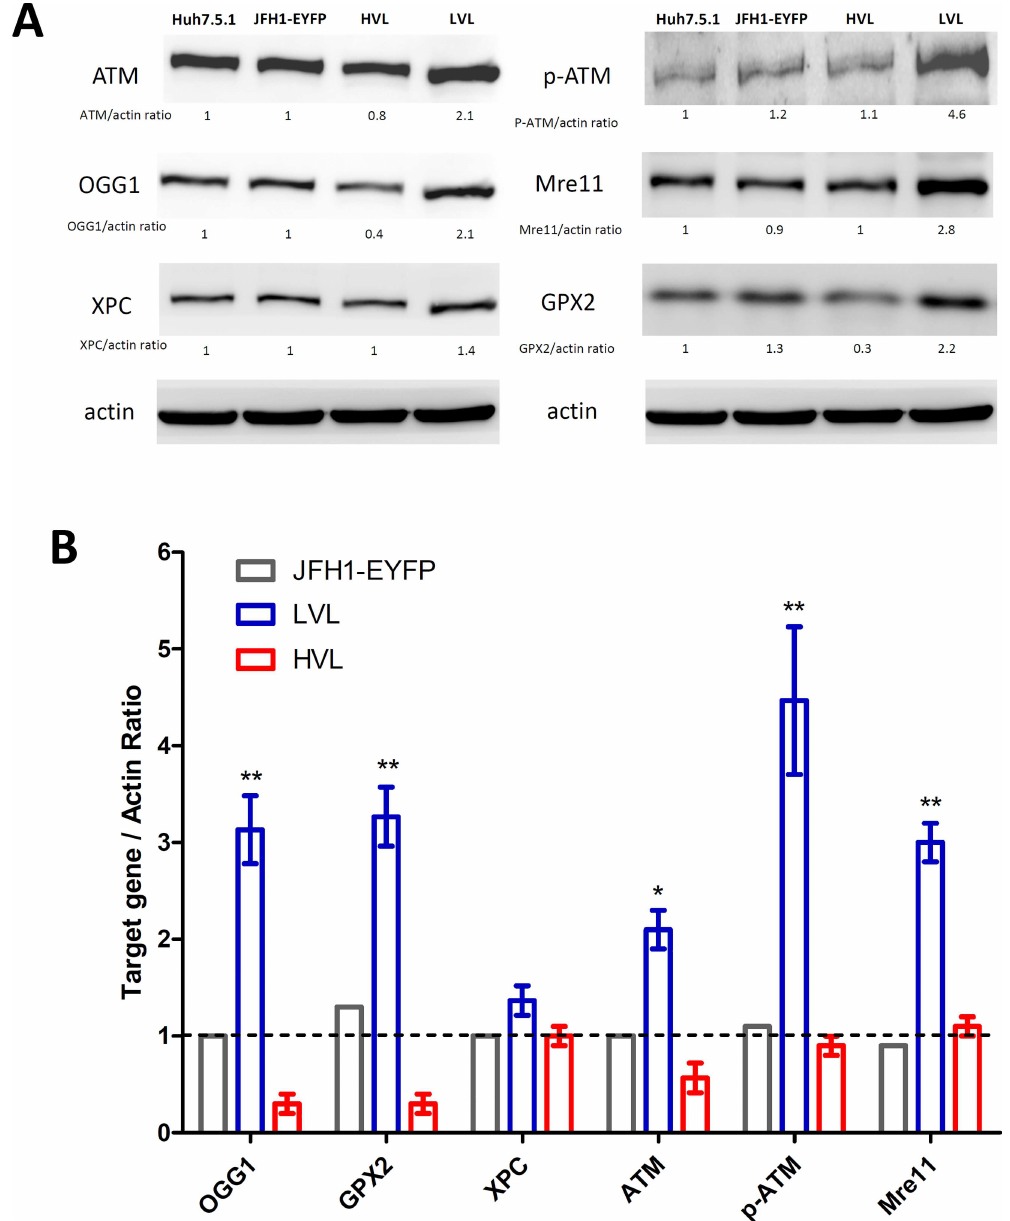
Fig 4. The protein expression levels of HVL and LVL sorted cells by western blotting. (A) The ATM, phospho-ATM, GPX2, MRE11, OGG1, and XPC levels were measuredby western blot analysis. The figure is representative of three independent experiments. (B) The relative fold activity was quantifiedusing AlphaImage software and normalizedto the expression of the internal actin control. * P < 0.05, ** P <